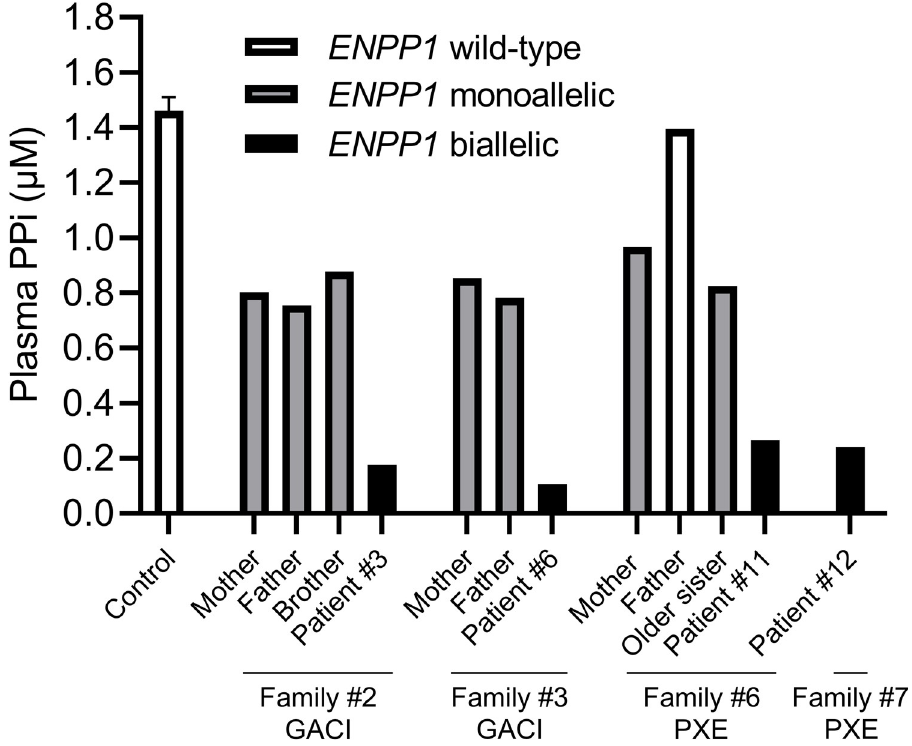
Fig 4. Plasma PPi concentrations in individuals with GACI or PXE and family members. Individuals with biallelic ENPP1 pathogenic variants, regardless of the diagnosis of GACI or PXE, had barely detectable PPi plasma concentrations. ENPP1 heterozygotes had intermediate PPi plasma concentrations. The physiologic PPi plasma concentrations were obtained from 9 healthy control volunteers. Data represent mean ±